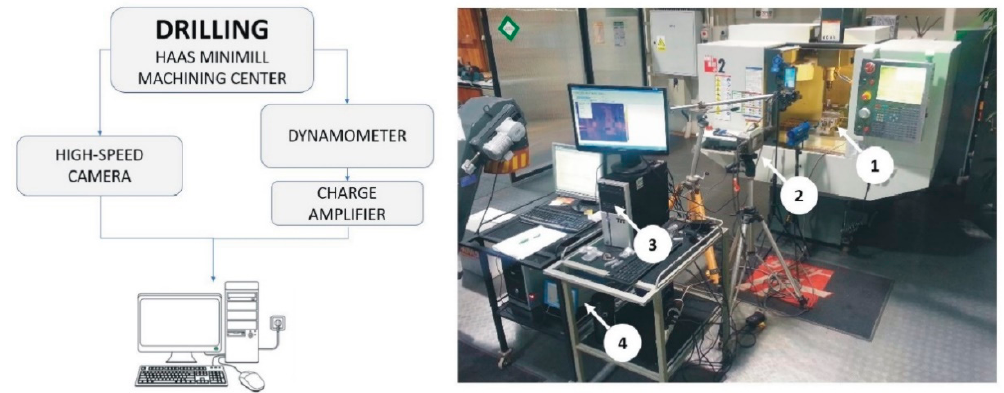
Figure 2. Measuring path scheme ( left ). Research stand ( right ). 1—dynamometer, 2—high-speed camera, 3—PC for data acquisition, 4—charge amplifier.